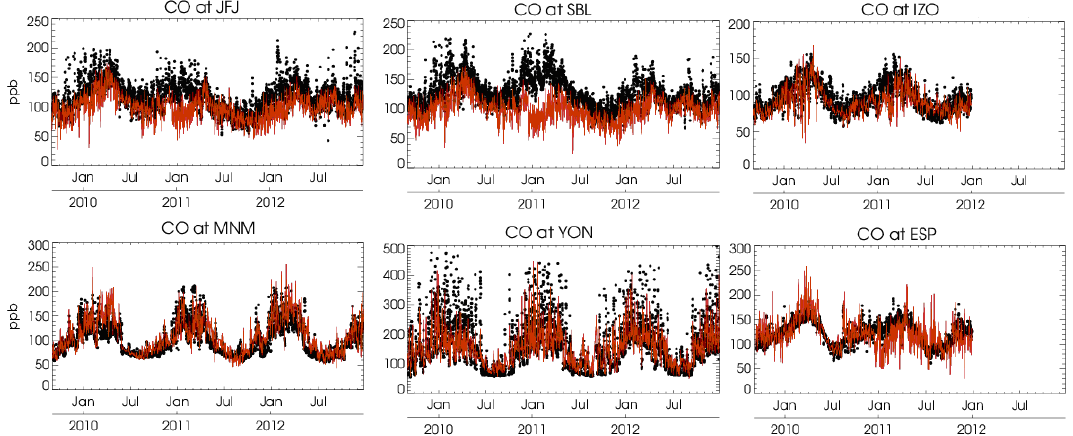
Figure 9. Time series plots of the MACC_osuite 6-hourly CO mixing ratios (red) and GAW surface observations (black) for Jungfraujoch, JFJ (Switzerland); Sonnblick, SBL (Austria); Izana Observatory, IZO (Tenerife); Minamitorishima, MNM (Japan); Yonagunijima, YON (Japan); and Estevan Point, EVP (Canada) during the period September 2009 to December 2012. Unit: